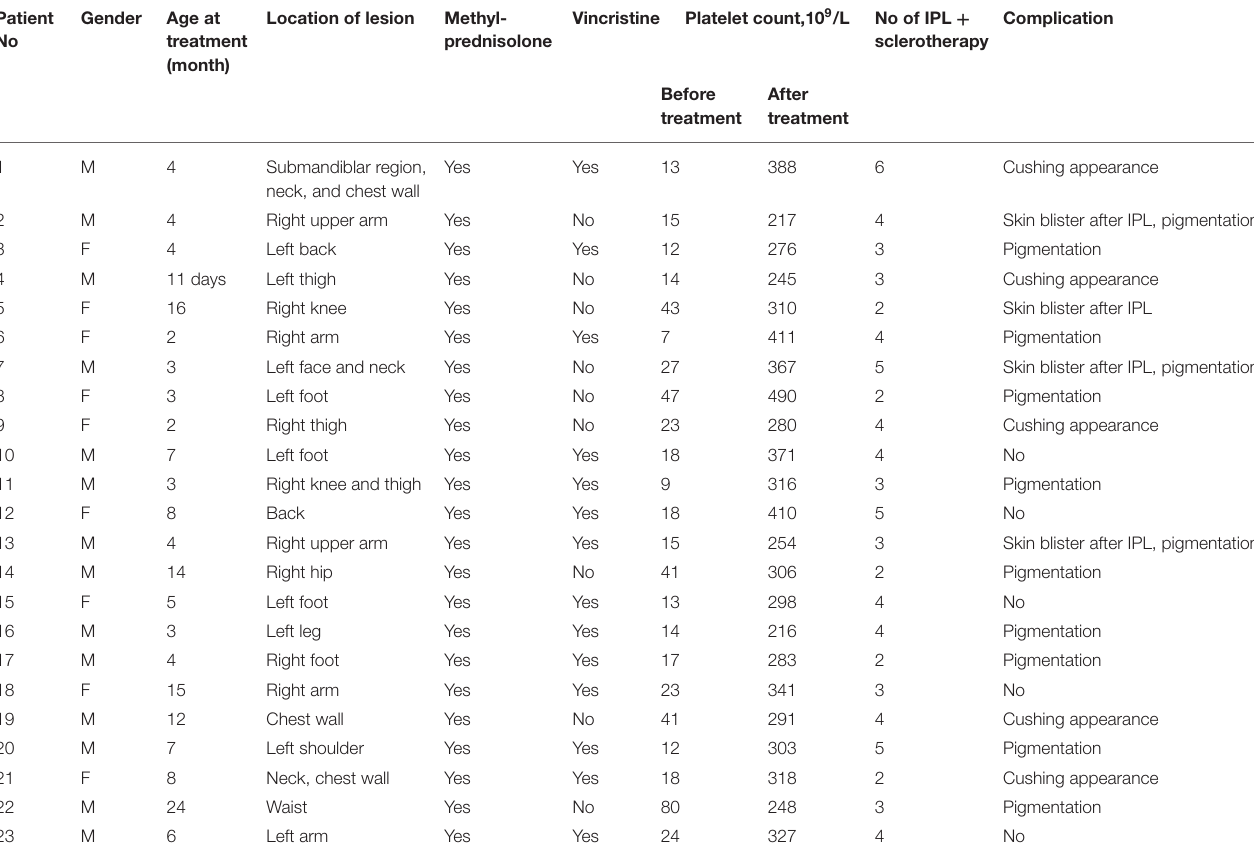
Complication sclerotherapy